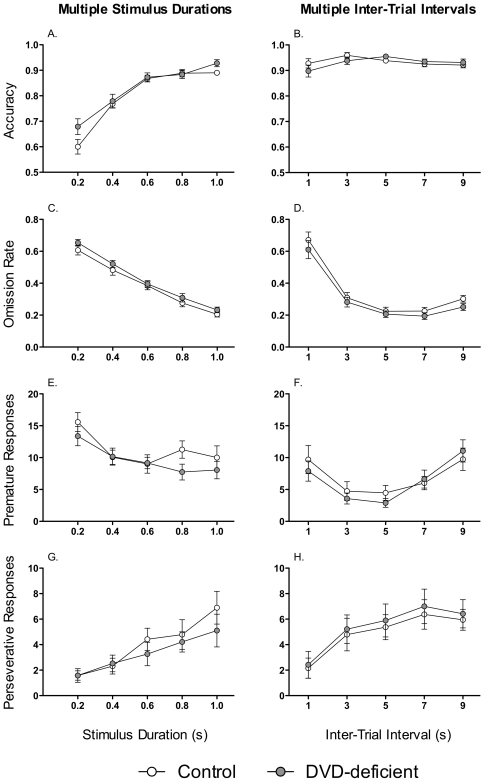
Performance of mice on the 5C-SRT with multiple stimulus durations (left) and multiple inter-trial intervals (right).This figure shows accuracy (A and B), the omission rate (C and D), premature responses (E and F) and perseverative responses (G and H) for control (n = 19) and DVD-deficient (n = 19) mice over the five different stimulus durations (0.2–1.0 s) and over the five different inter-trial intervals (1–9 s). Data are expressed as mean ± SEM.